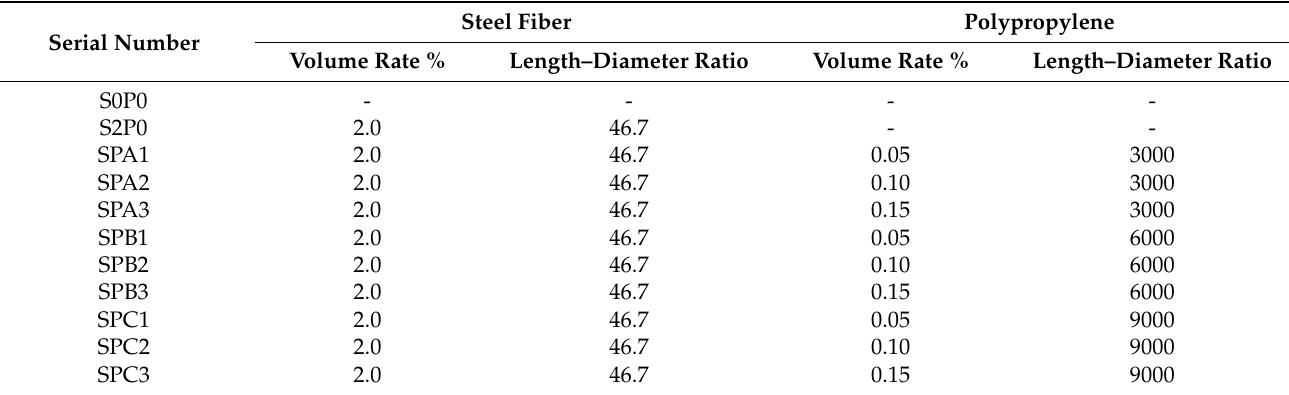
Figure 3. ( a ) SHPB device; ( b ) high-speed camera; ( c ) DIC method-related flow chart. Table 6. Orthogonal test